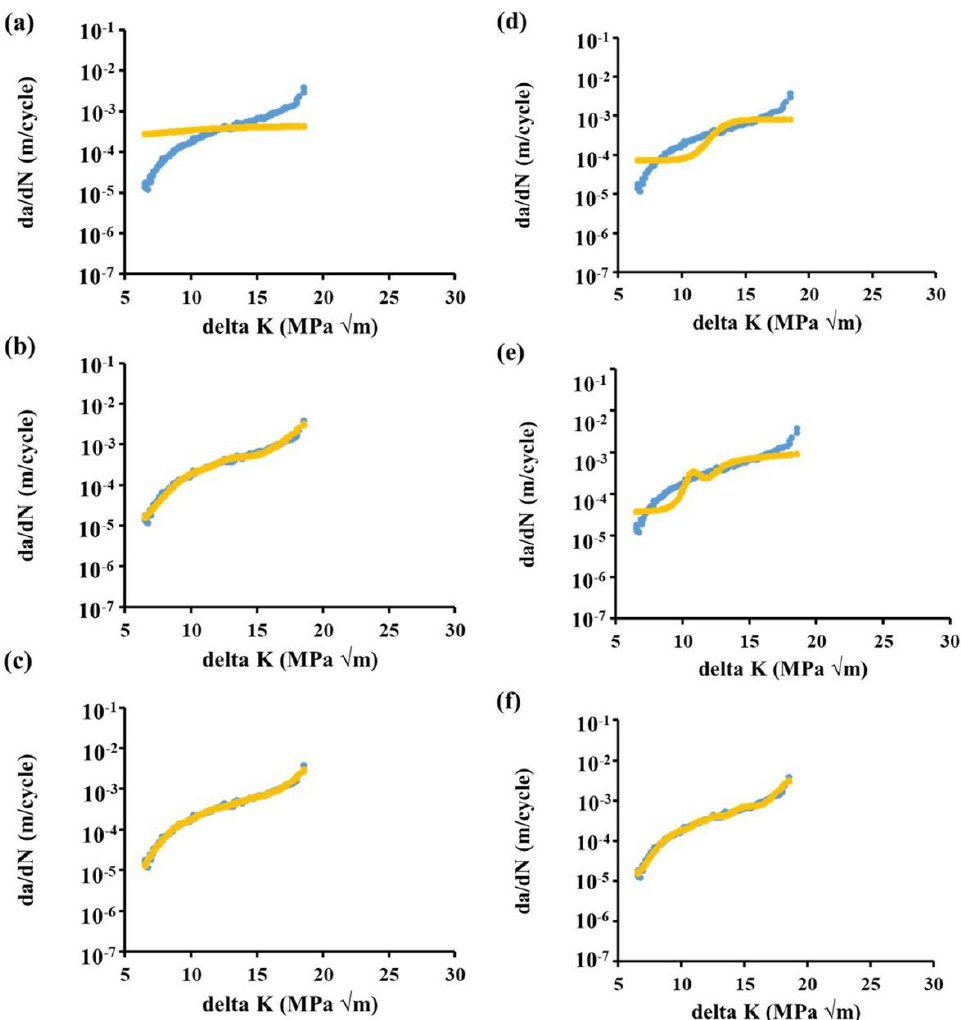
Figure 5. Influence of neurons of extreme learning machine (ELM), on testing CR 250 samples, using sigmoidal activation function: ( a ) 1 neuron, ( b ) 5 neurons and ( c ) 10 neurons and, tanh activation function: ( d ) 1 neuron, ( e ) 5 neurons and ( f ) 13 neurons.